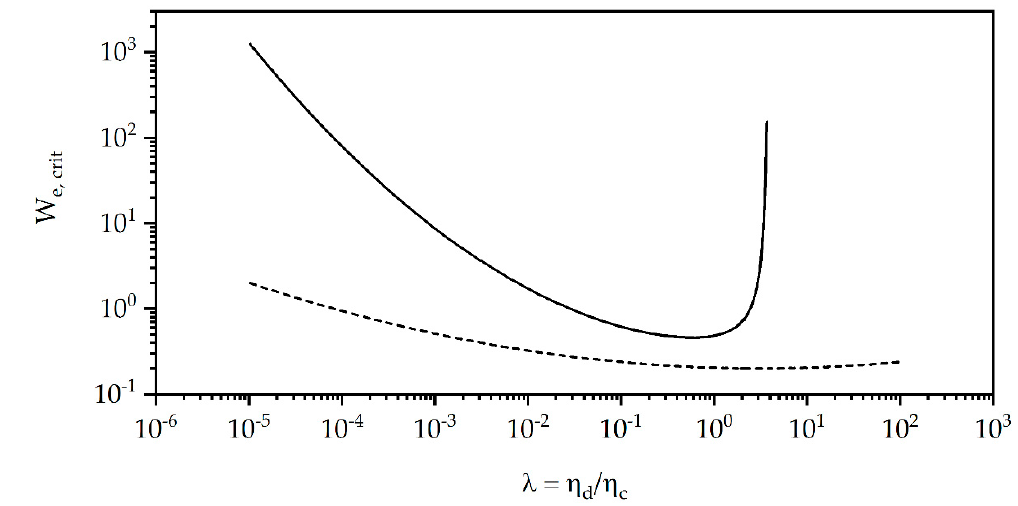
Figure 2. Critical Weber number W e , crit . for shear flow (solid line) and elongational flow (dotted line) as a function of the viscosity ratio λ of dispersed phase η d to continuous phase η c from empirical equations according to de Bruijn [45] and Peters et al. [46].